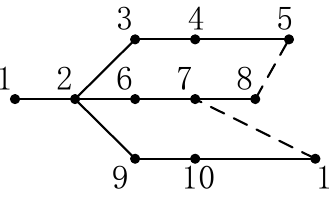
Figure 1. An illustration of 11-bus system with loops.